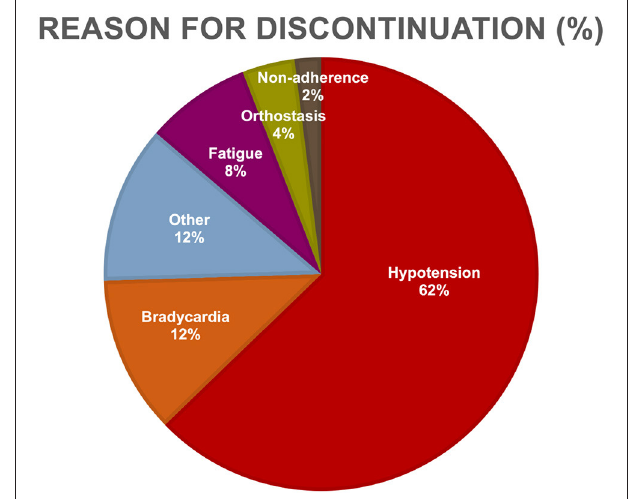
FIGURE 3 | Reasons for beta-blocker discontinuation. Listed are the reasons for discontinuation of behhta-blocker therapy among cardiac amyloid patients. The most common reasons for stopping beta-blocker therapy were hypotension, bradycardia, fatigue, and orthostasis.